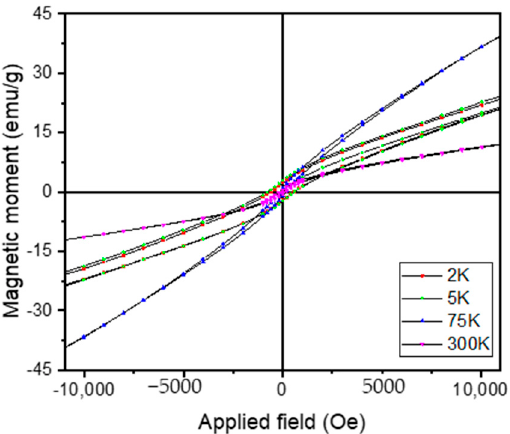
Figure 8. Minor hysteresis loops of Mn 52 Al 46 C 2 alloy at various temperatures. Coercive fields observed at low T confirm results from Figure 5.